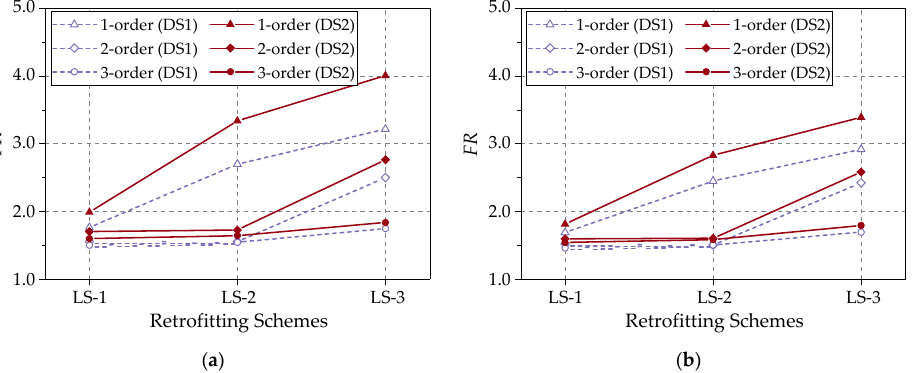
Figure 9. Frequency ratios ( FR ) of DS1 and DS2 damage states MD ‐ RC frames with and without retrofitted by three layout schemes: ( a ) MS1 mainshock; and, ( b ) MS2 mainshock.